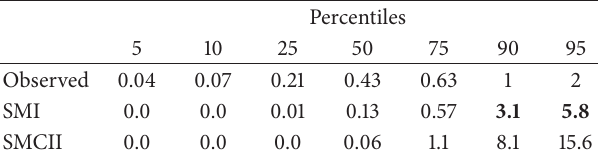
Table 4: Analysis of stream flow (m 3 /s) percentiles during model validation.